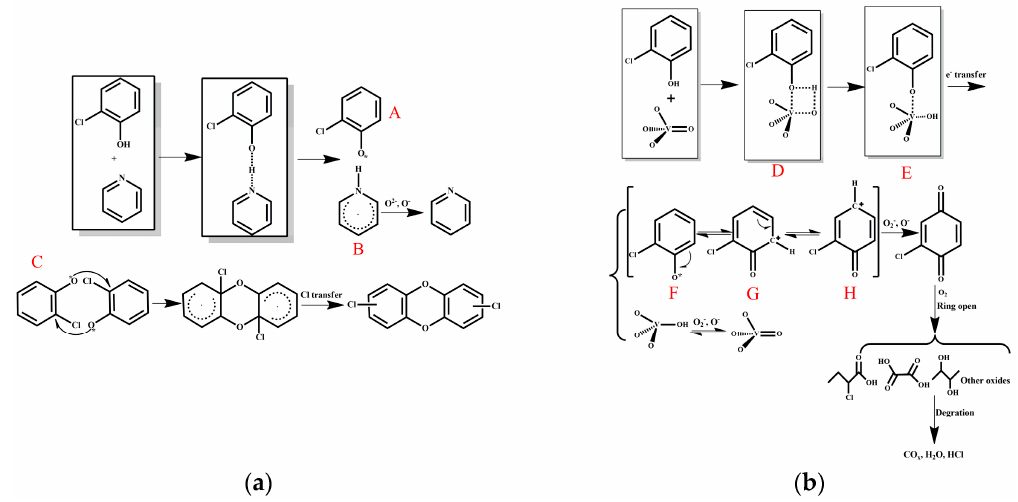
Figure 10. Reaction mechanisms of o ‐ CP oxidation involving ( a ) AC–NH 3 ∙ H 2 O and ( b ) AC–V.